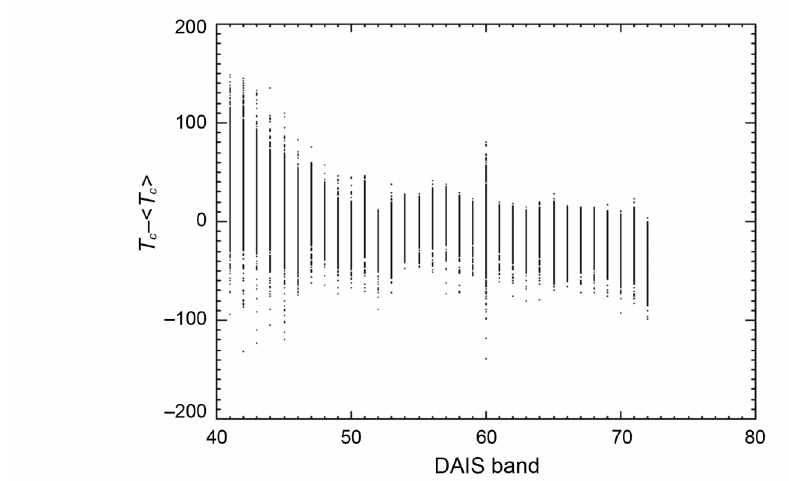
Fig. 5. T c −< T c > deviation.